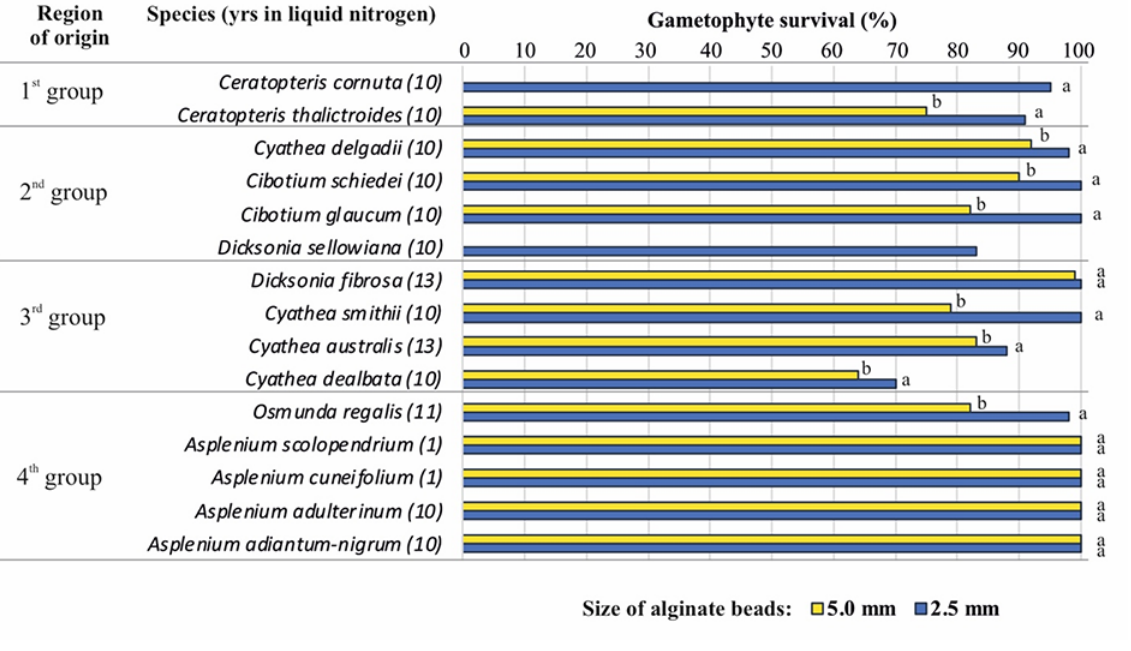
Figure 4 Fern species cryopreserved as gametophytes using the encapsulation-dehydration technique. Gametophytes were precultured for 2 weeks with 0.25 M sucrose and 10 μM abscisic acid (ABA). Alginate beads were 5 mm or 2.5 mm in size. Incubation for 7 days in the dark was applied during the recovery culture of small beads. With Ceratopteris cornuta (P. Beauv.) Lepr. and Dicksonia sellowiana (Pr.) Hook., only small capsules were used. Species were categorized by ecogeographic region of origin: first group – water ferns of the humid tropics; second group – ferns of tropical and submontane rain forest; third group – mild, subfreezing winters; fourth group – temperate species with winter temperatures as low as − 32